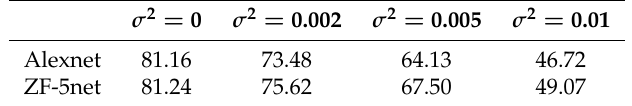
Table 1. The recognition rates (%) of the Alexnet and ZF-5net with different intensity of Gaussian